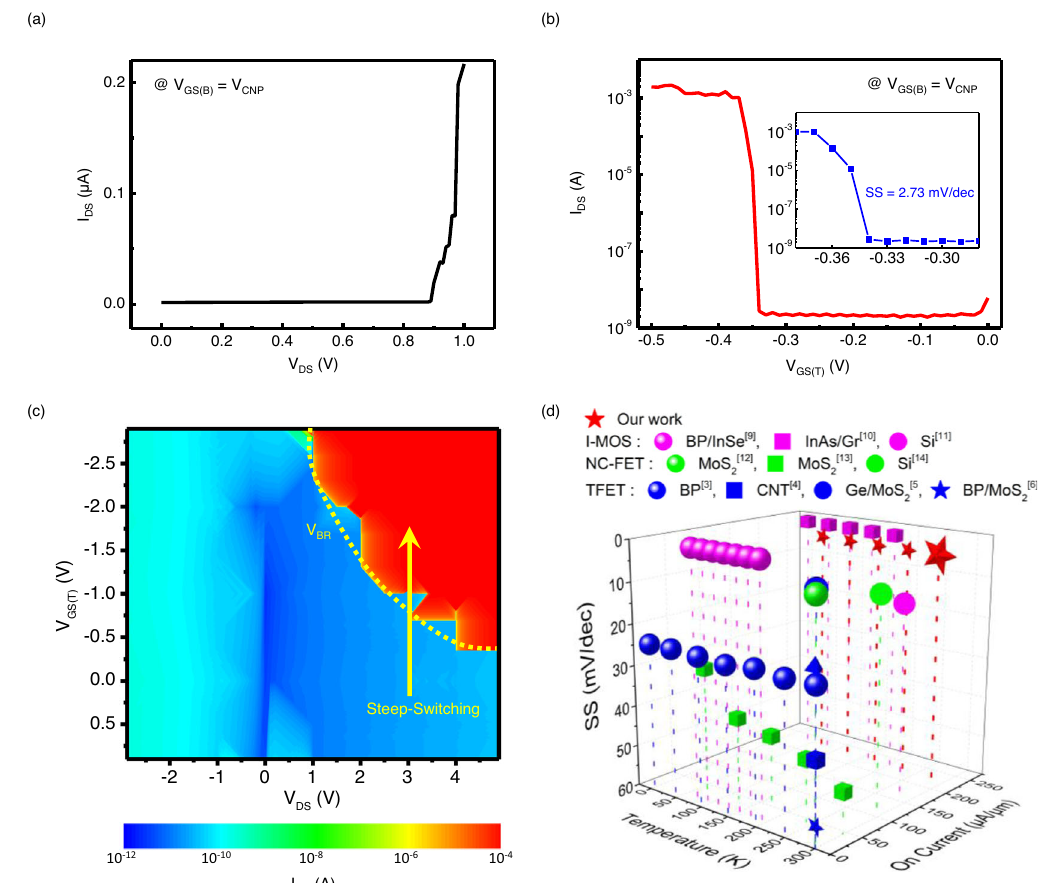
Fig.2|PerformancesofWSe 2 I 2 FET.a I DS – V DS characteristicsatthechargeneutral point ( V CNP ). One can see an abrupt rise over 0.88V. b I DS – V GS(T) characteristics at room temperature and a magni fi ed view of the subthreshold region. The on/off current ratio exceeds 10 6 , and the SS is 2.73mV/dec. c Contour plot representing the channel current ( I DS ) as a function of various V DS (from − 3 to 5V) and V GS(T) (from 1 to − 3V). Steep-switching behavior is observed only at the avalanche bias